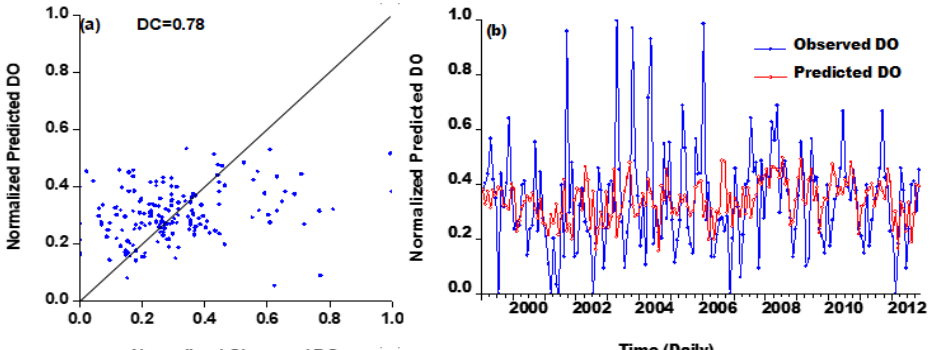
Fig. 4: Evaluation of MLR model a) scatter plot (b) observe versus computed time series of DO